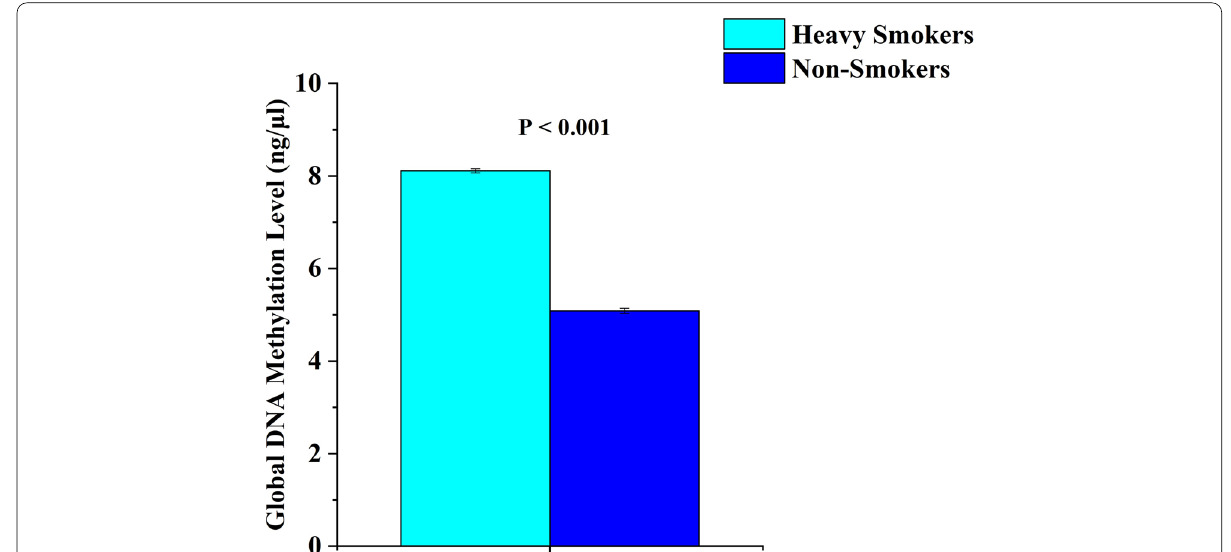
Fig. 2 Global DNA methylation level at spermatozoa of heavy smokers compared to non-smokers. P < 0.05: significant; P